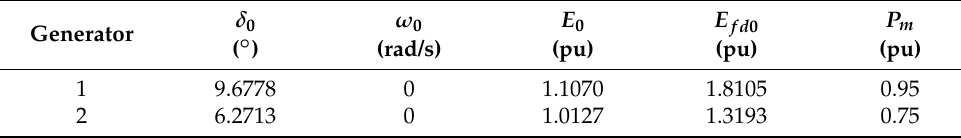
Table 5. Initial conditions for the dynamic